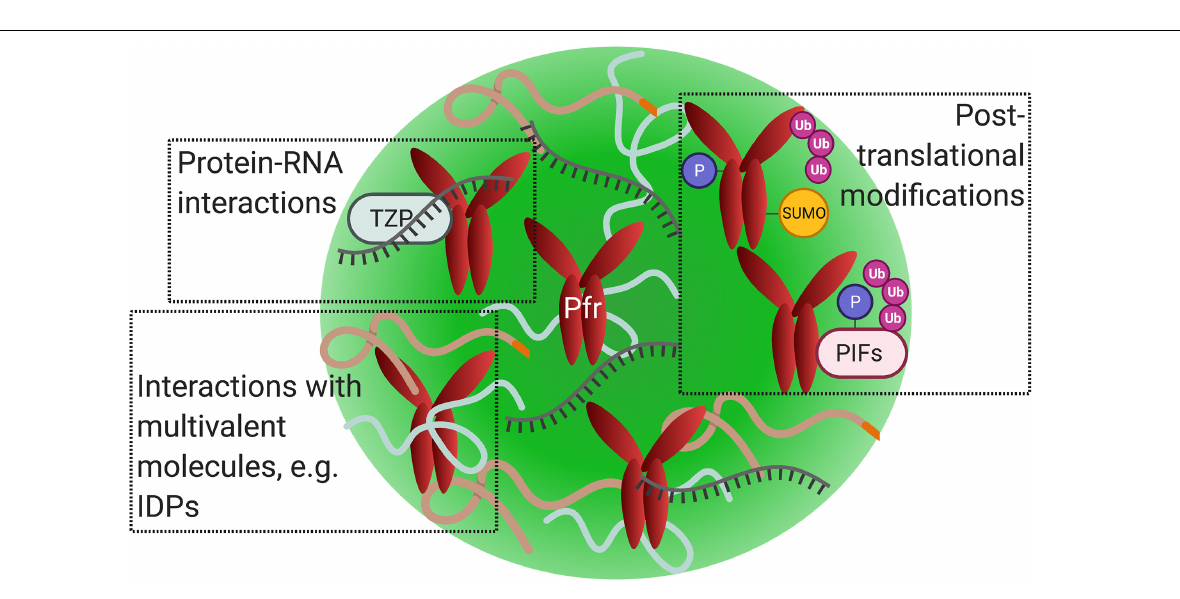
FIGURE 3 | Phytochrome photobodies are a controllable system for studying factors that influence liquid-liquid phase separation in vivo. Within Arabidopsis nuclei (ovals), active phytochrome can transition from a single diffuse phase throughout the nucleoplasm (1) into two distinct phases: one with a low concentration that is evenly distributed throughout the system and a denser phase that takes the shape of liquid droplets, or photobodies (2), and finally into large photobodies (3). Green represents nuclear phy-Pfr, and the green circles represent phytochrome photobodies. Environmental and cellular factors influence the formation and dissipation of phytochrome photobodies. Increasing red-light intensity and the concentration of presumptive scaffold proteins, such as HMR, PCH1, RCB, and NCP, promote the formation of photobodies. Conversely, warm temperatures and low red:far-red ratios under foliar shade conditions promote the dissipation of photobodies.